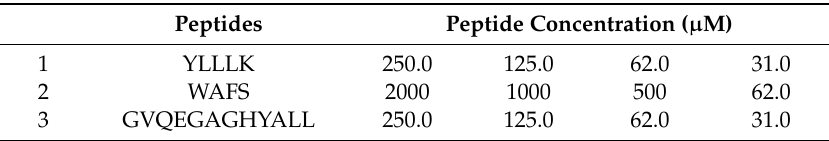
Table 1. Peptide concentrations used for kinetic